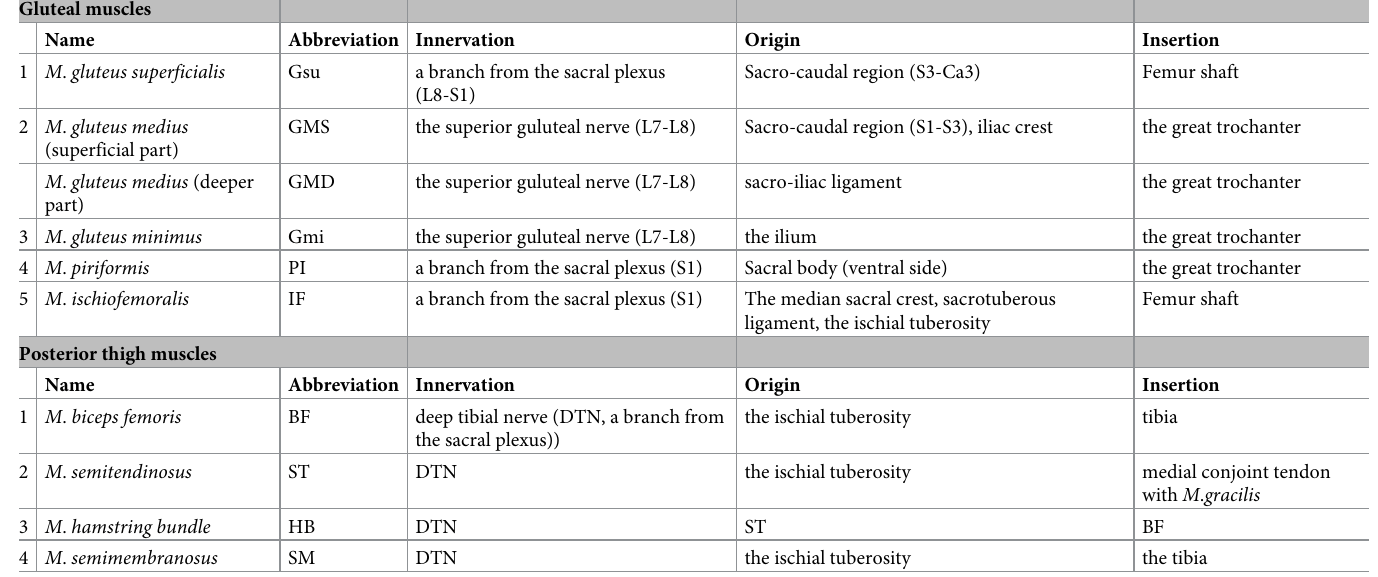
Table 2. Observed koala muscles in this